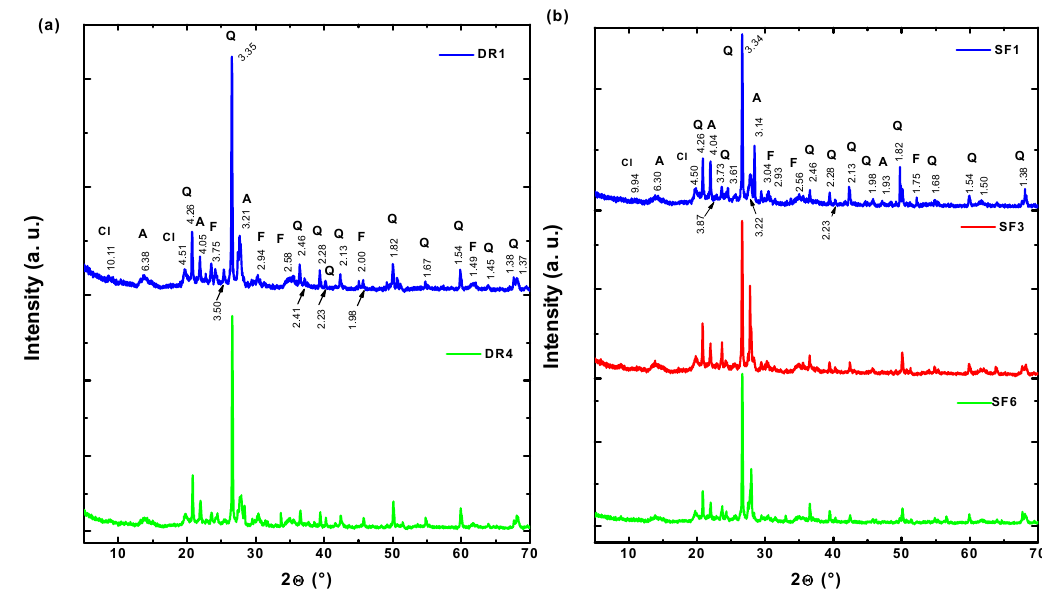
Figure 4. X-ray diffraction (XRD) patterns of bulk sediments of the ( a ) DR and ( b ) SF cores for the superficial (DR1 and SF1: 0–5 cm), intermediate (SF3: 10–15 cm), and deep (DR4: 15–20 cm and SF6: 25–30 cm) sections of each core. Main minerals identified are marked as Q (quartz), F (feldspar), A (albite), and Cl (clay minerals). The numbers correspond to 2Θ characteristic positions of some peaks for each mineral identified expressed in Armstrong (Å).